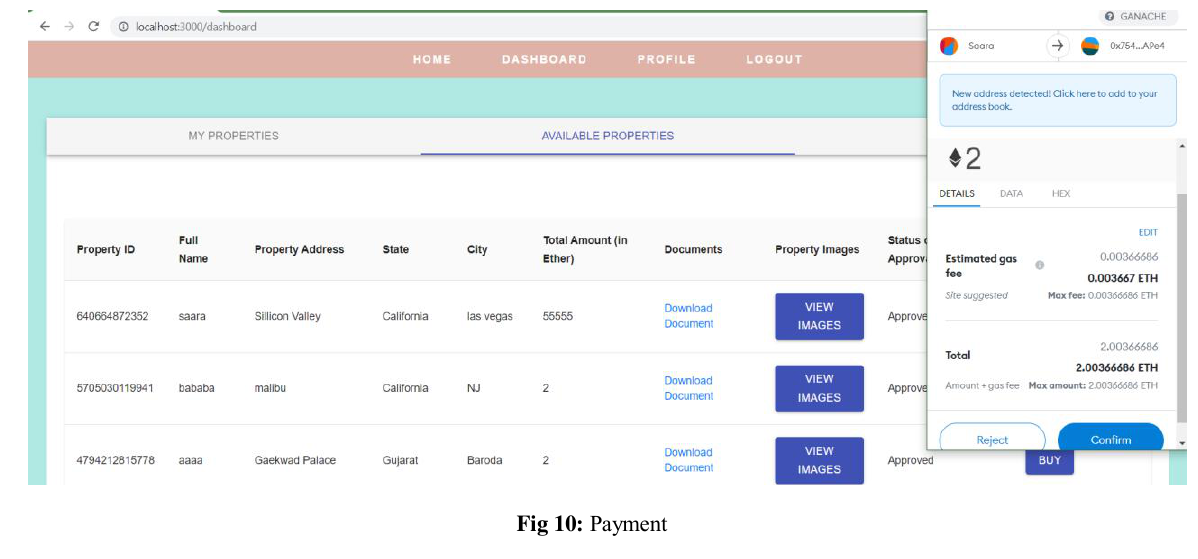
Fig 8: ` Property is visible in the ‘Available Properties’ section of the dashboard.